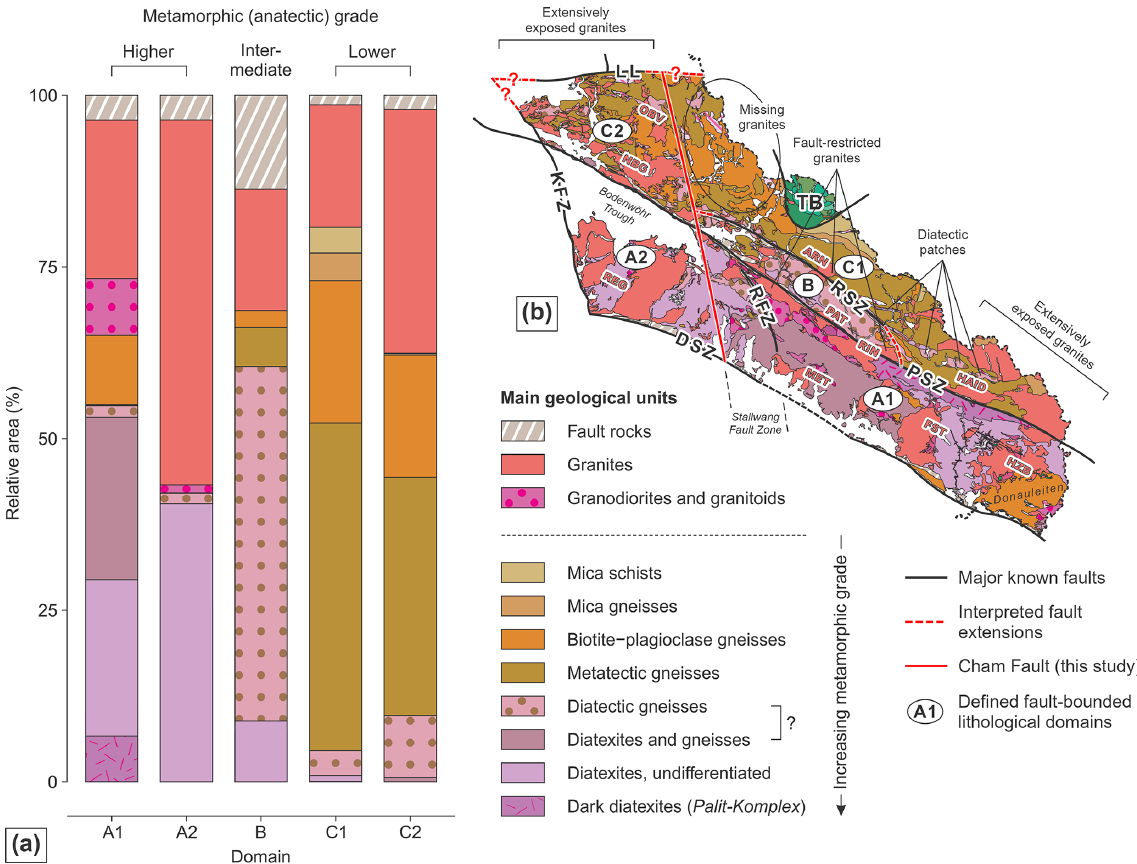
Figure 3. Statistical and spatial distribution of exposed lithologies. Five fault-bounded domains with characteristic rock inventories can be identified (A1, A2, B, C1, and C2). (a) Stacked bar plots illustrating the relative area proportions of the exposed lithologies in each of the domains (calculations based on geological maps from Teipel et al., 2008 and Galadí-Enríquez et al., 2009b). (b) Detailed geological map of the studied area along the southwestern Bohemian Massif (modified from Teipel et al., 2008; Galadí-Enríquez et al., 2009b). An important fault (Cham Fault) is proposed in the northwestern part of the study area separating domains A1 and C1 from A2 and C2. Fault